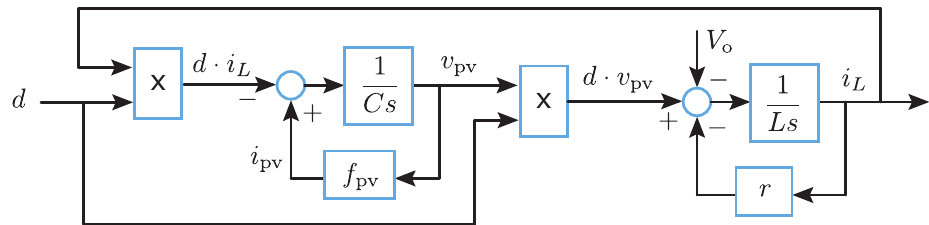
Figure 3. Block diagram of the large-signal